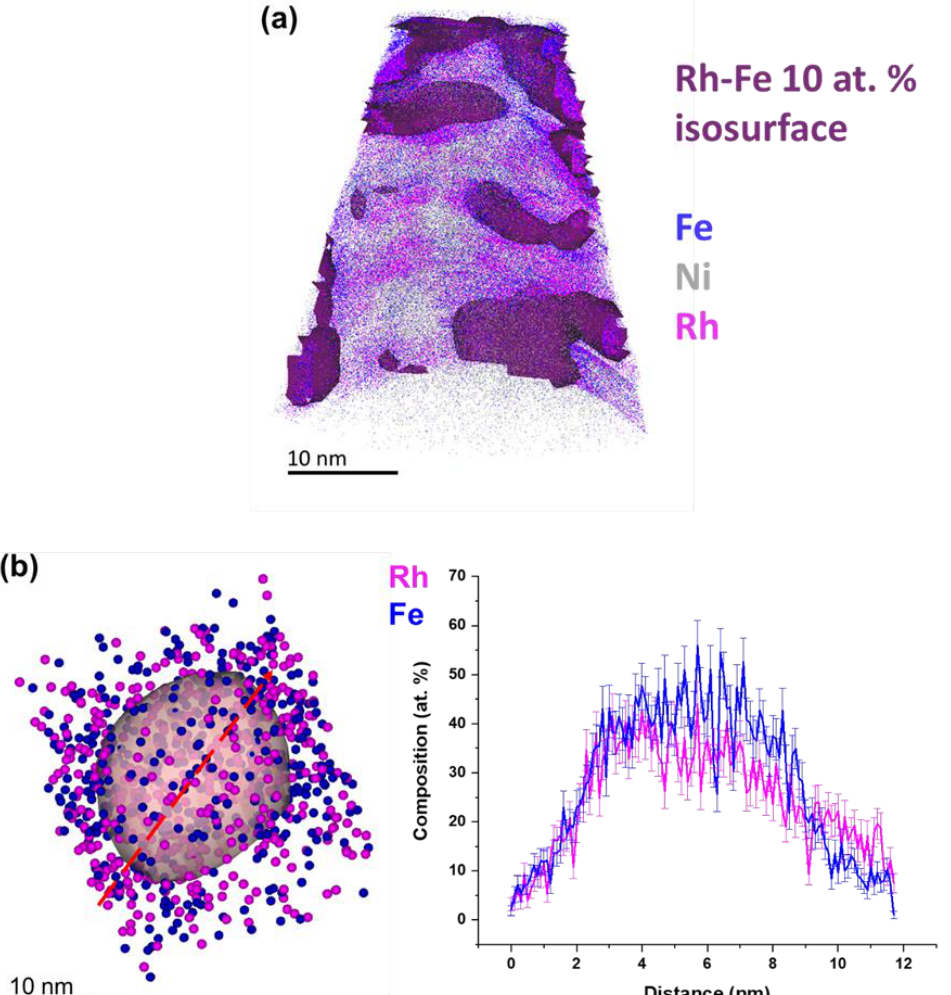
Figure 5. Atom probe tomography of FeRh nanoparticles synthesized in acetone and argon atmosphere. ( a ) 3D atom map of FeRh nanoparticles in Ni deposit. Blue, purple, and grey dots mark the reconstructed positions of Fe, Rh, and Ni, respectively. Detected FeRh nanoparticles are highlighted by 10 at% FeRh iso-composition surfaces. ( b ) Extracted FeRh nanoparticle (25 at% of FeRh iso-composition surface) and line scan of selected FeRh nanoparticle.